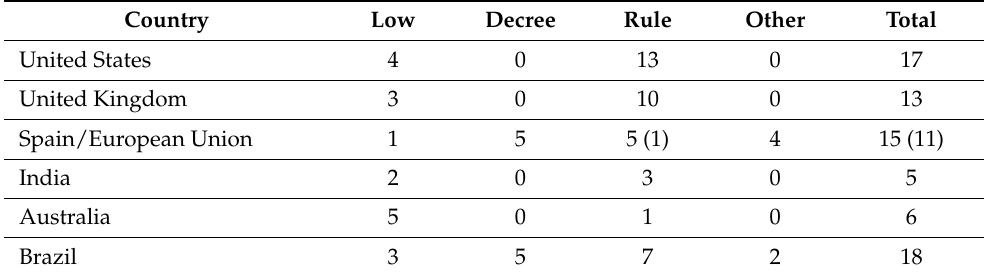
Table 4. Legislation for renewable